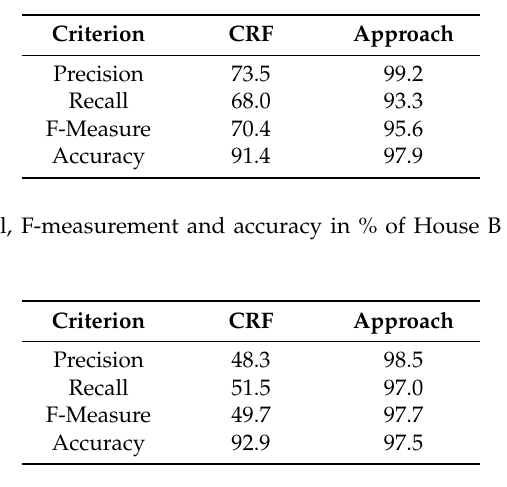
Table 3. Precision, recall, F-measurement and accuracy in % of House A in comparison with the benchmark (CRF).